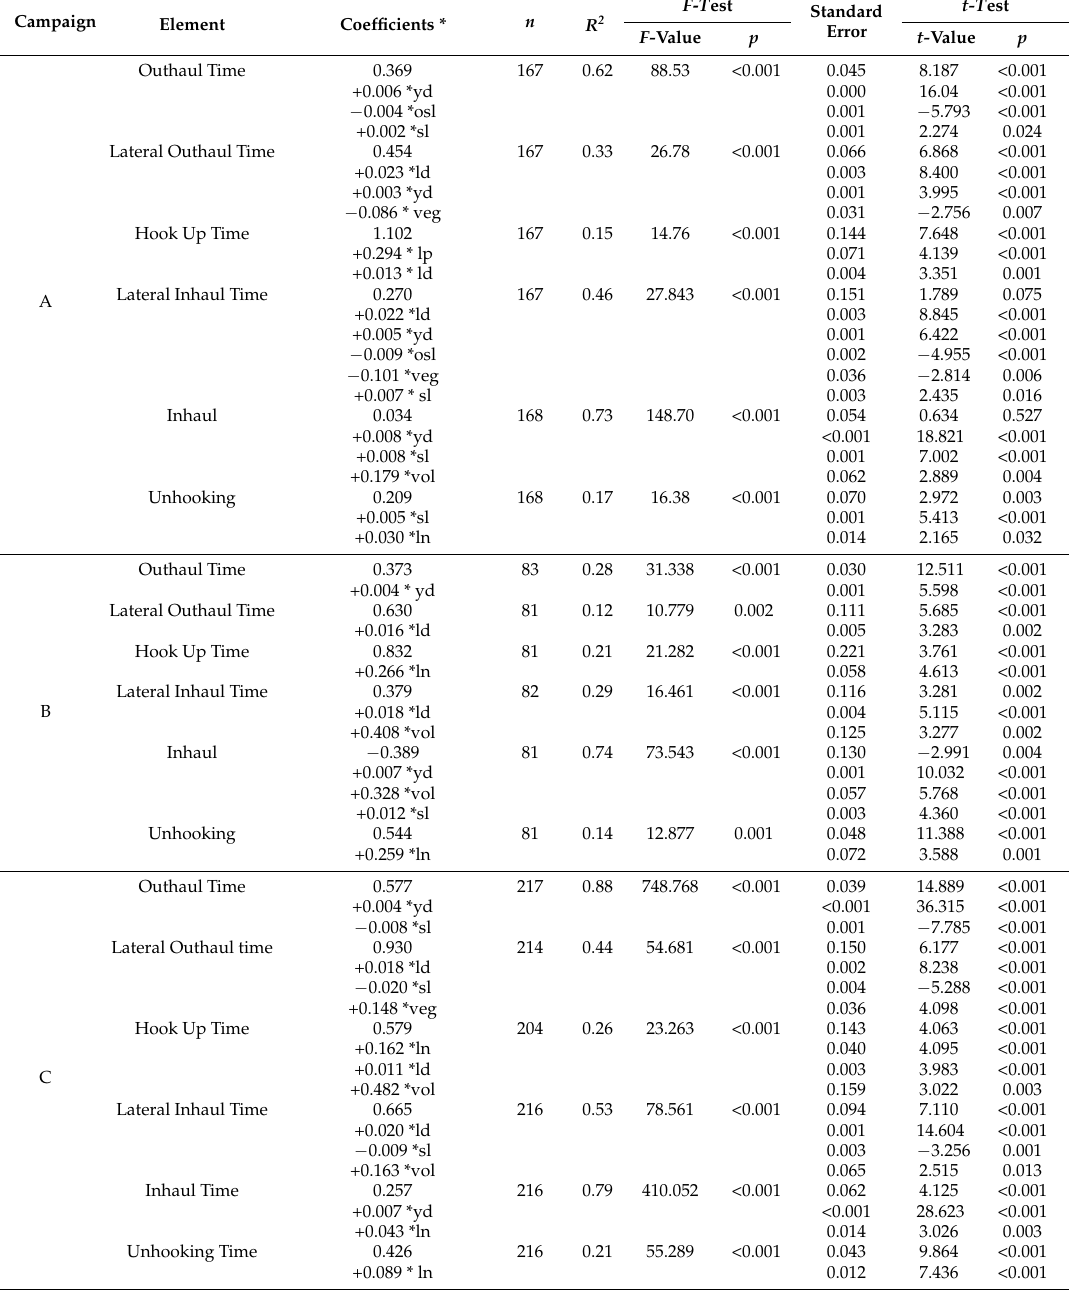
Table A5. Stepwise multiple regression models and test statistics for the individual cycle elements of the four data collection campaigns based on qualified observations after removals of extreme values outside three times the standard deviations ( n